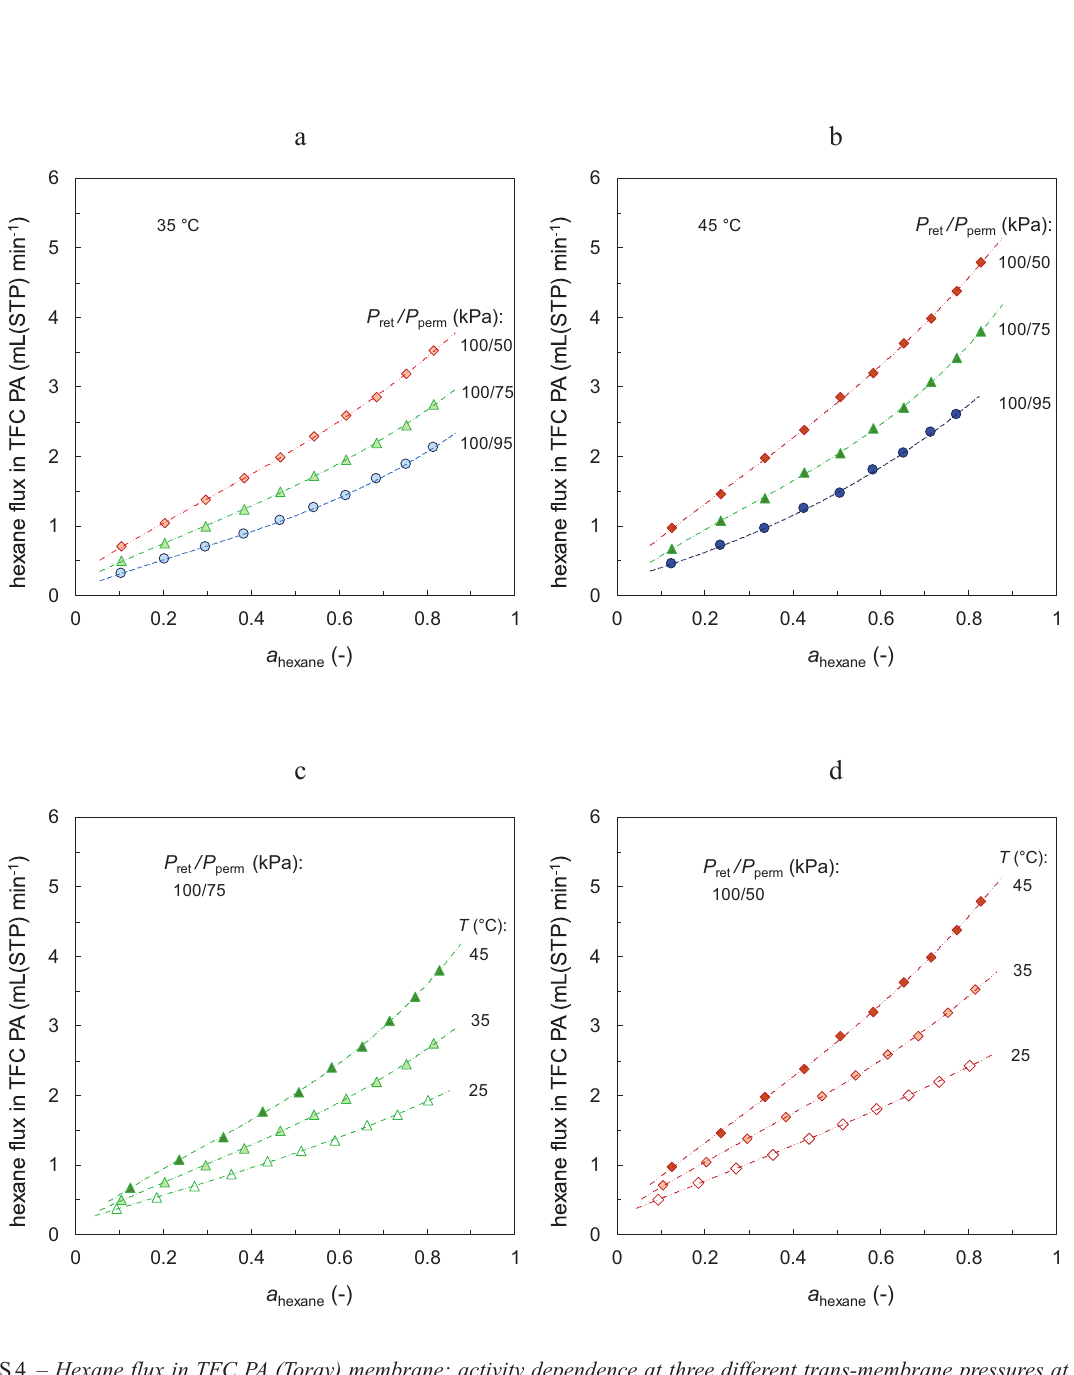
Fig. S4 – Hexane flux in TFC PA (Toray) membrane: activity dependence at three different trans-membrane pressures at a) 35 °C and b) 45 °C, activity dependence at three temperatures at trans-membrane pressure c) 25 kPa and d) 50 kPa; The lines are intended as a guide to the eye.